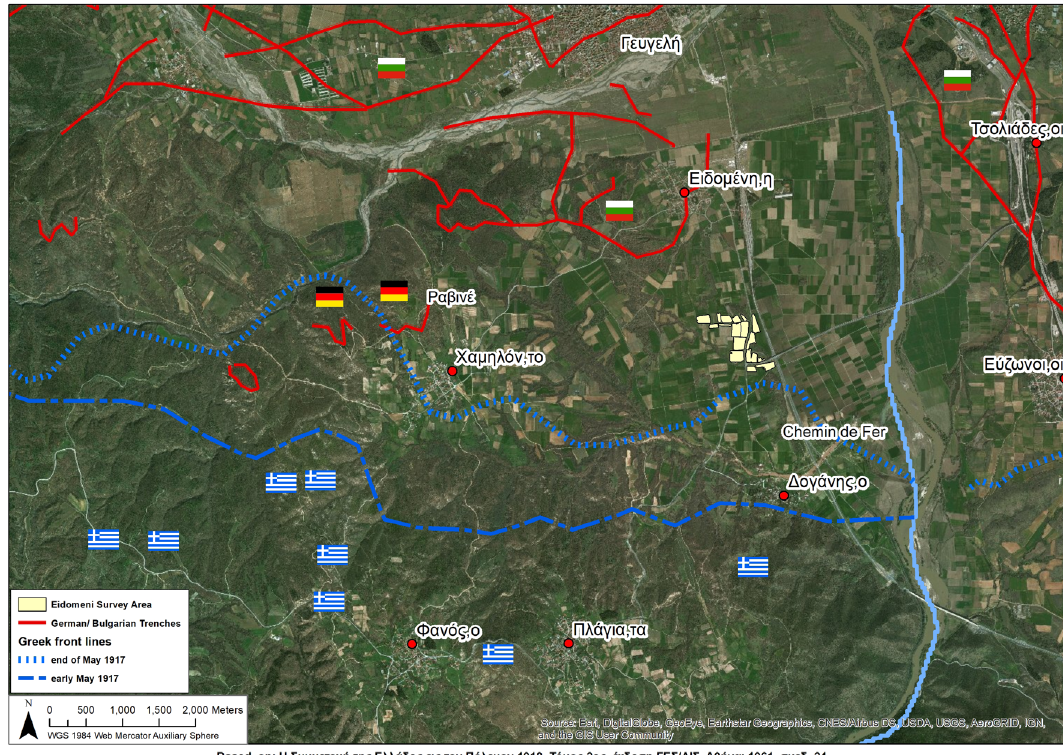
Figure 18. The battle on Ravine height, the “battle-scape” near Idomeni in 1917 and the contribution of Greek army in the Macedonian Front (based on fig. 24 from: GES/DIS (1961). I summetohi tis Ellados eis ton Polemon 1918. Athens (WGS 1984, WebMercator Auxiliary